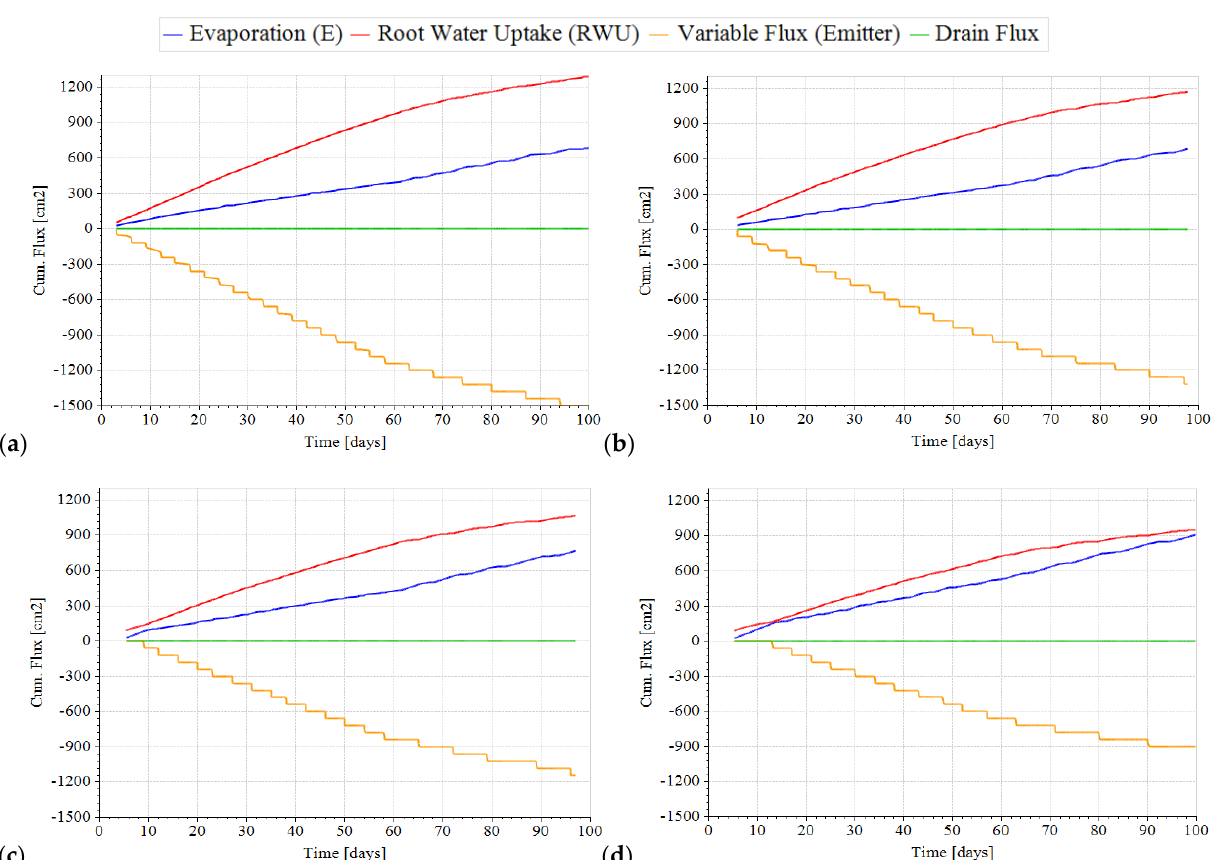
Figure 7. Cumulative root water uptake, evaporation, free drainage, and variable fluxes for ( a ) T 90, ( b ) T 80 , ( c ) T 70 , and ( d ) T 60 when activating root growth option.